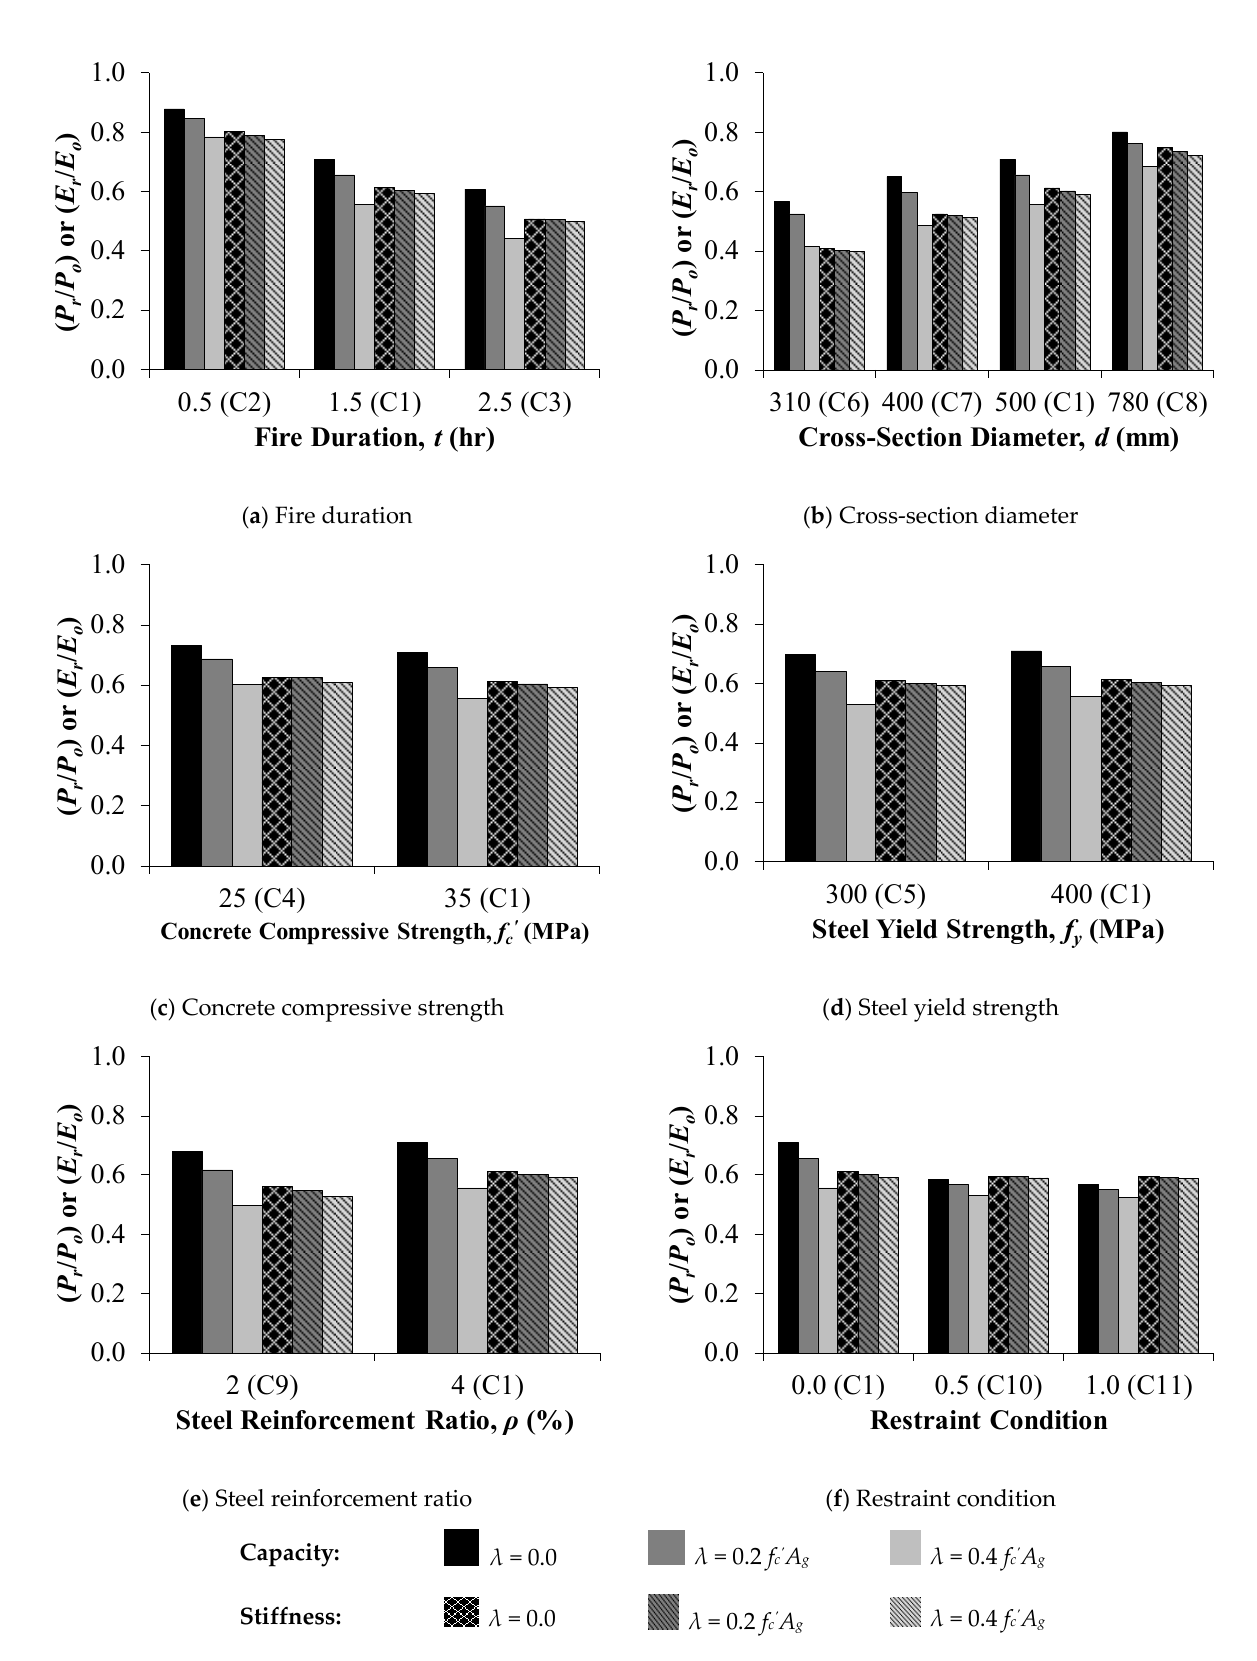
Figure 14. Influence of varying the examined parameters on the axial capacity and stiffness of cir- cular columns.